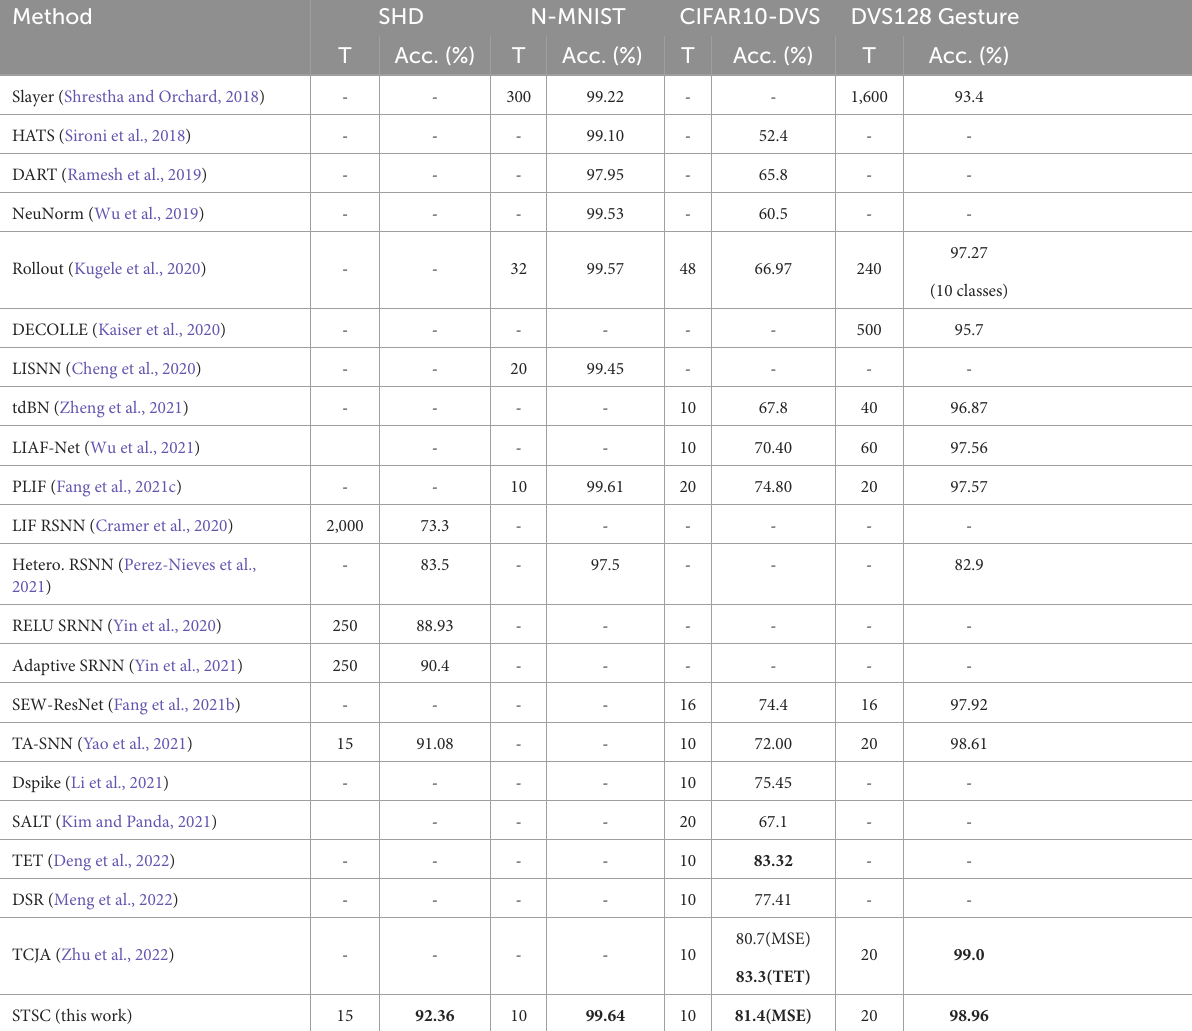
TABLE 4 Performance comparison between the proposed method and the state-of-the-art methods on different